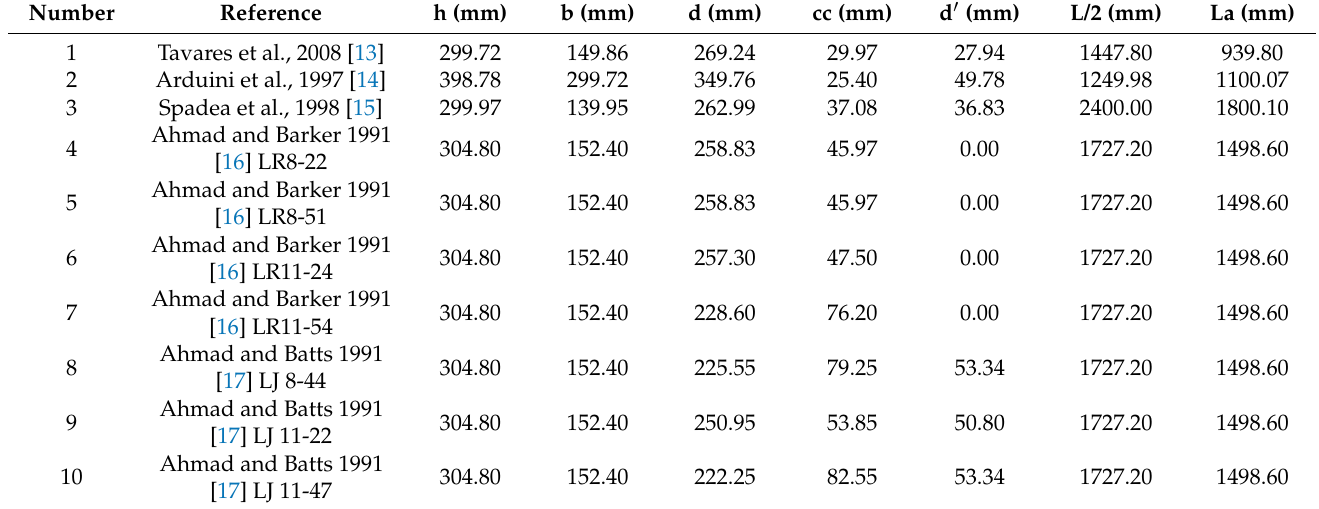
Table 2. The geometrical parameters for the tested beams.